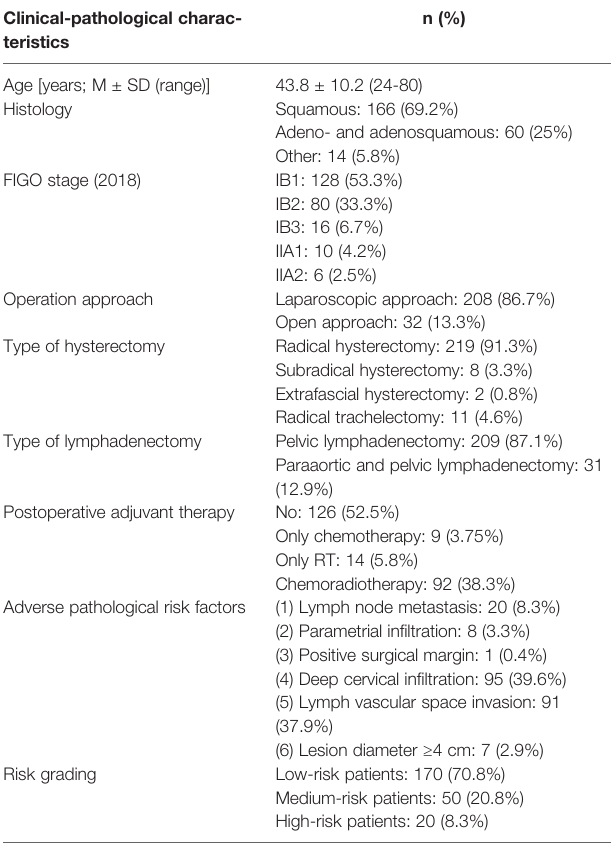
TABLE 1 | Patients ’ clinical-pathological characteristics (N = 240). Clinical-pathological charac-